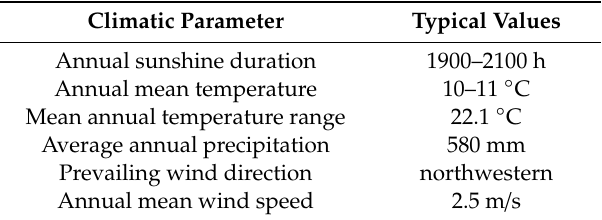
Table 1. Average values of basic climatic parameters of Hungary